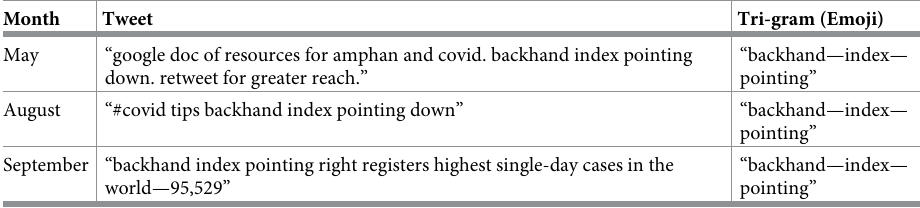
Table 4. Selected examples of processed tweets that are captured in most prominent tri-grams.